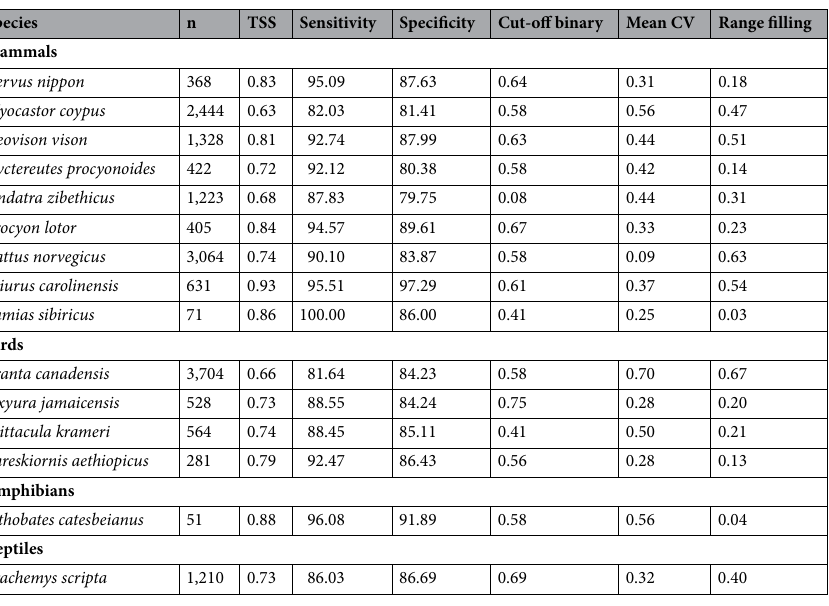
Table 2. Results on the predictive ability of the European models fitted with certain datasets. n indicates the number of presence points used to fit the model. TSS is the true skill statistic. Sensitivity is the proportion of positives correctly predicted. Specificity is the proportion of absences correctly predicted. Cut-off binary shows the value of suitability (0–1) that maximized the sum of sensitivity and specificity and was used to convert the continuous prediction into binary. Mean CV is the mean coefficient of variation among models in the ensemble prediction standardized between 0 and 1. Range filling represents the fraction of the grid-cells classified as ‘presence’ in the binary map that overlapped with the observed records on species